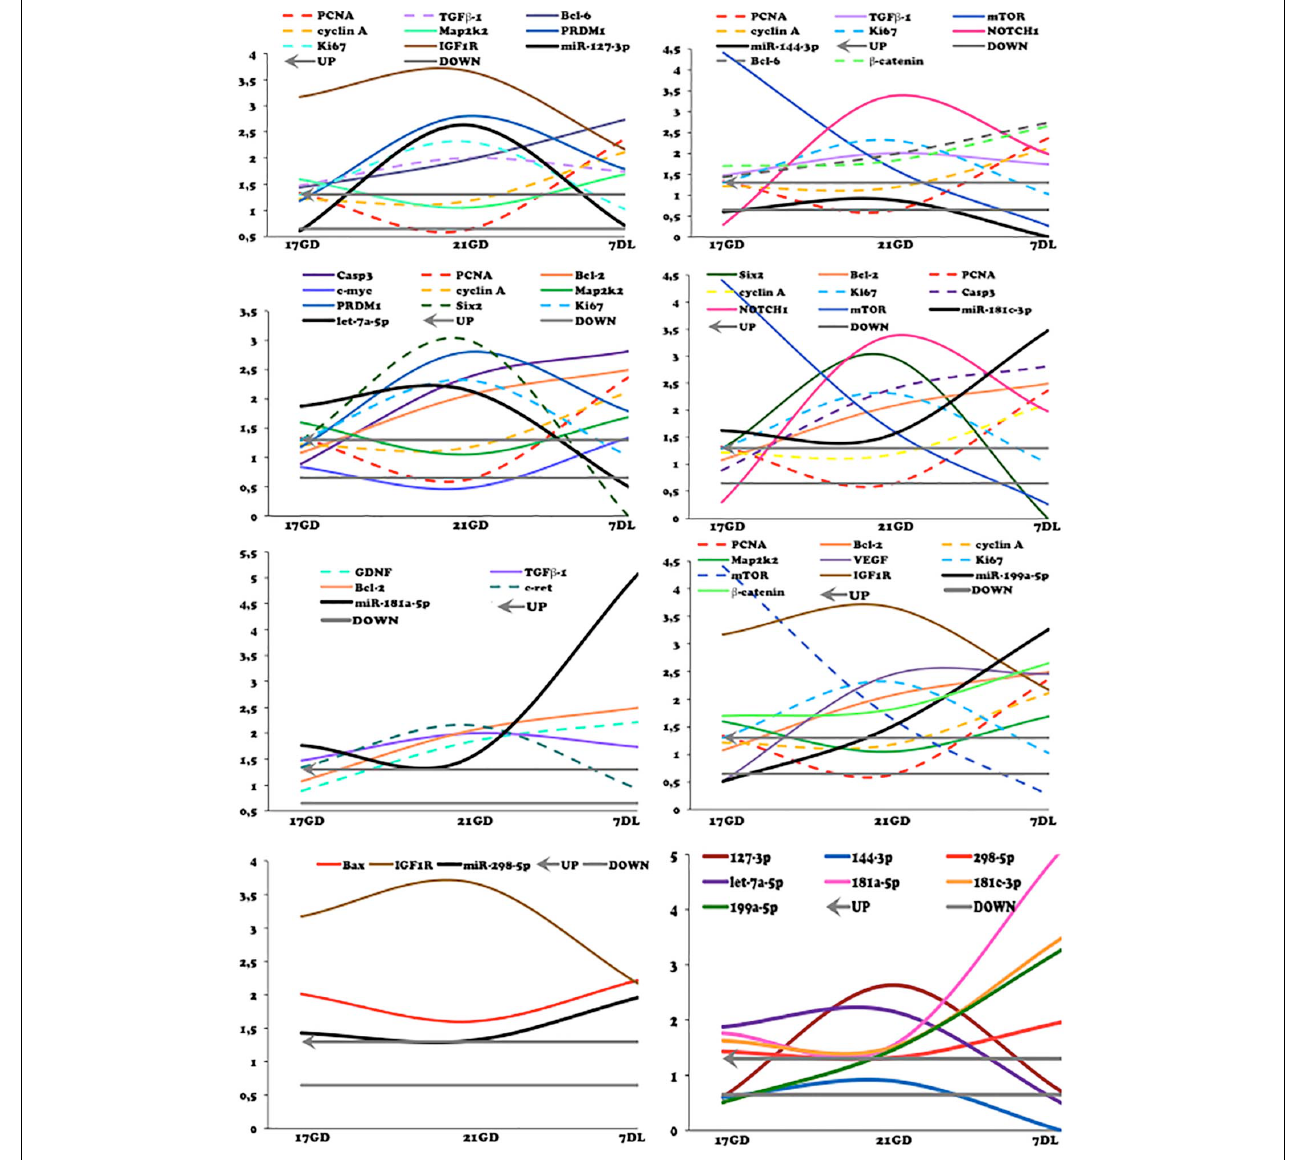
FIGURE 12 | Curves of validated miRNAs and their predicted target mRNAs obtained by miRTarBase and Ingenuity (solid lines) and from literature (dashed line). The expression was normalized with GAPD. The authors established a cutoff point variation of 1.3 (upwards) or 0.65 (downwards), and data are expressed as fold change (mean) concerning the control